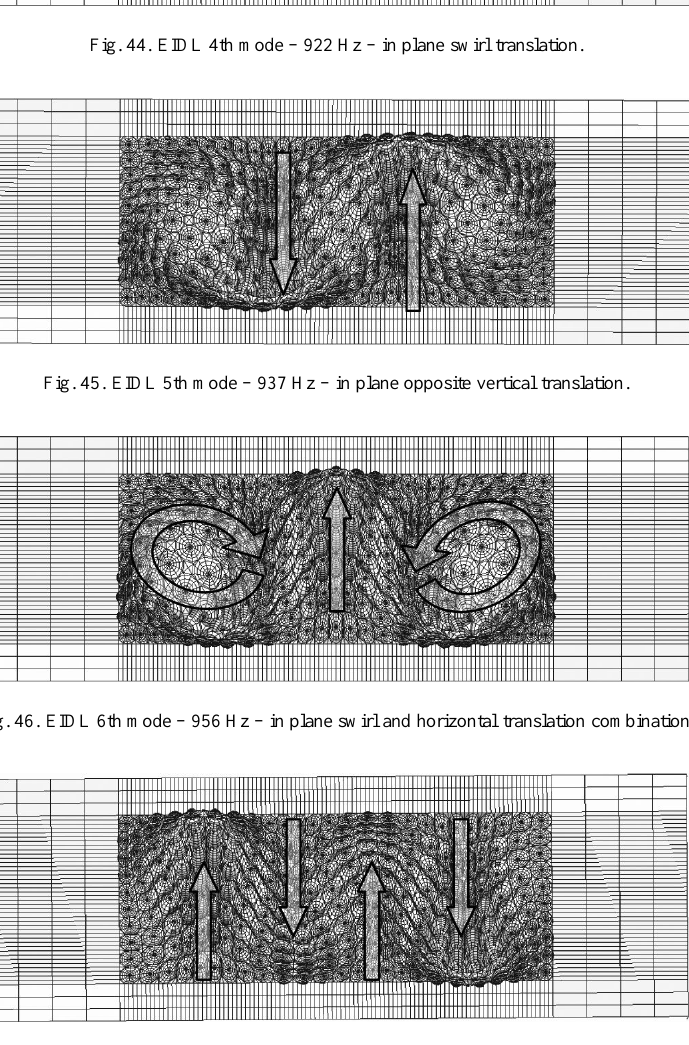
Fig. 47. EIDL 7th mode – 965 Hz – in plane quadruple opposite vertical